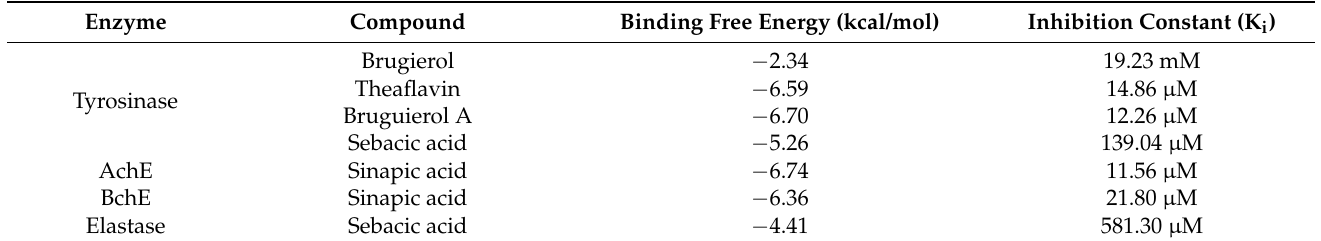
Table 9. Binding free energy and calculated inhibition constant of the docked